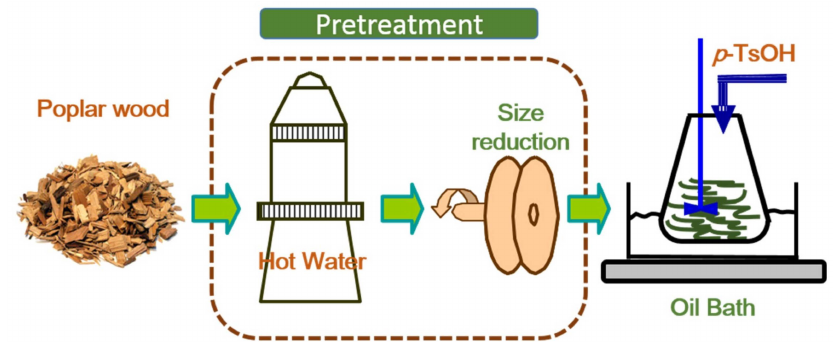
Figure 1. A schematic experimental flow diagram for enhancement of hydrotropic fractionation of poplar wood using autohydrolysis and disk refining